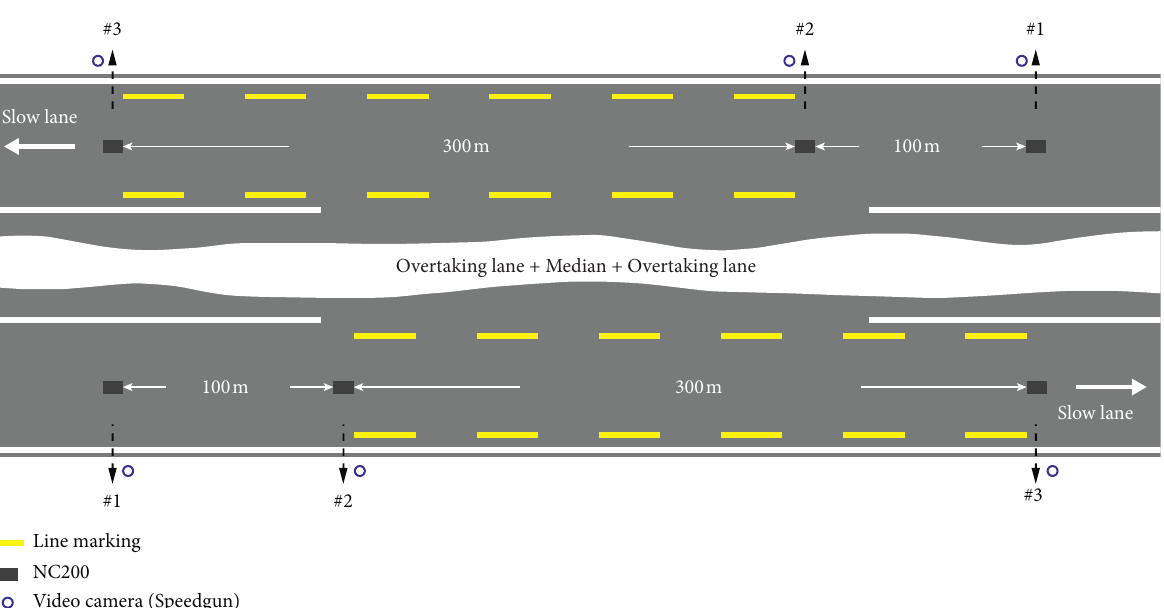
Figure 3: Layout of traffic analyzers and cameras. Here, the roadway was intentionally depicted as straight for a better illustration. The figure was not proportionally illustrated concerning the dimensions of various elements and was edited and elaborated from Ding et al. [14].